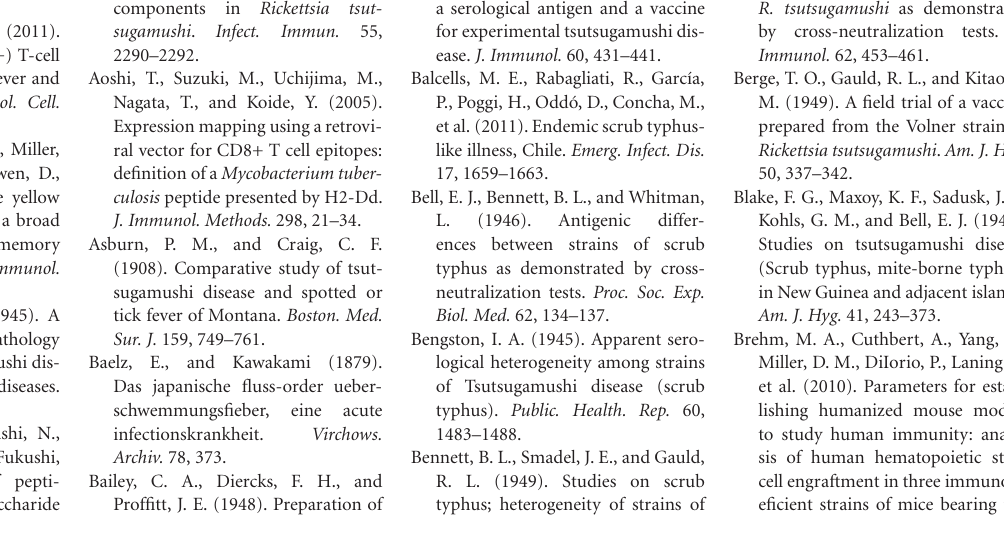
microvessel (arrows) and in adjacent mononuclear leukocytes (asterisks). The section is counterstained with hematoxylin and eosin. (B) Analysis of the lungs of the same animals (original magnification 100 × ) with the same alkaline phosphatase technique shows multiple foci of oriential antigen in the alveolar walls. Courtesy of Thomas